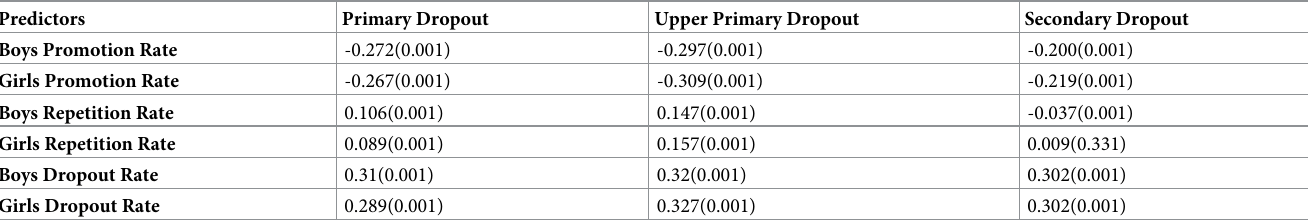
Table 3. Bivariate spatial association between dropouts and their predictors.